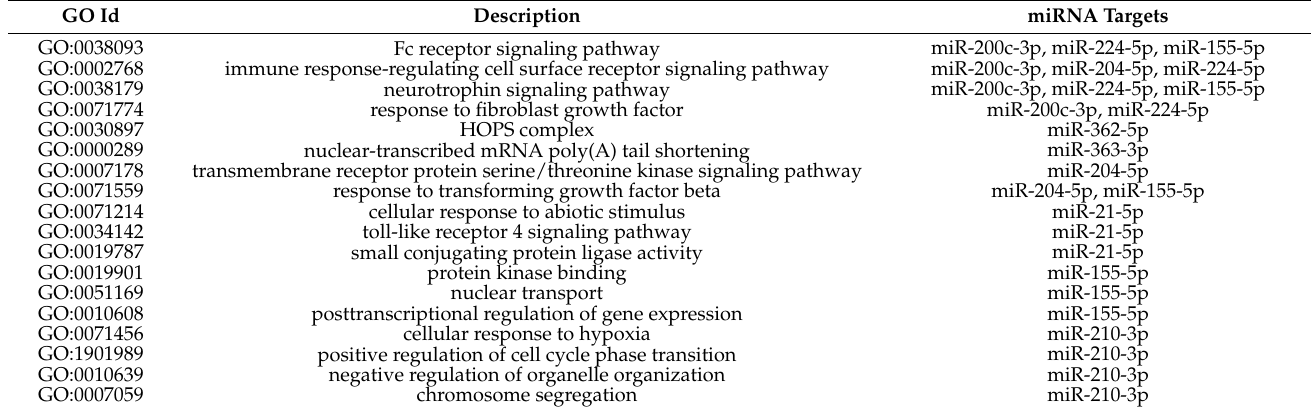
Figure 5. The survival rate analysis of ccRCC patients with deregulation expression of miRNA-224 and miRNA-210. ( a ) Patients with high expression (red line) of miRNA-224 have worst hazard ratio (HR) in ccRCC G2 than in G4; ( b ) Patients with high expression (red line) of miRNA-210 have higher survival rate although its massive upregulation in ccRCC tumors. Table 1. Gene ontology (GO) terms for targets of commonly deregulated miRNA in ccRCC. GO